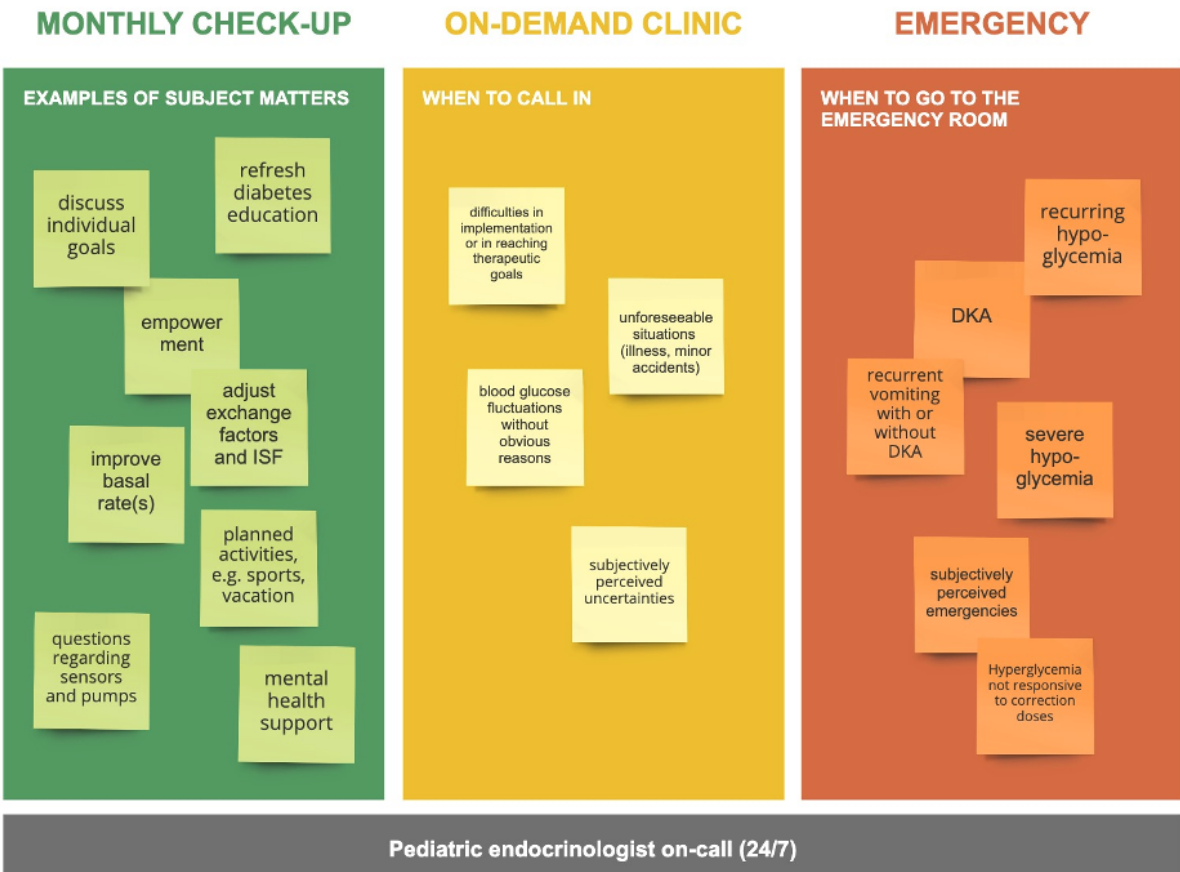
Figure 5. The triage system for on-demand consultations; risk assessments; and the emergency management of severe hypoglycemia, DKA, or other emergencies that are subjectively perceived as serious. DKA: diabetic ketoacidosis; ISF: insulin sensitivity